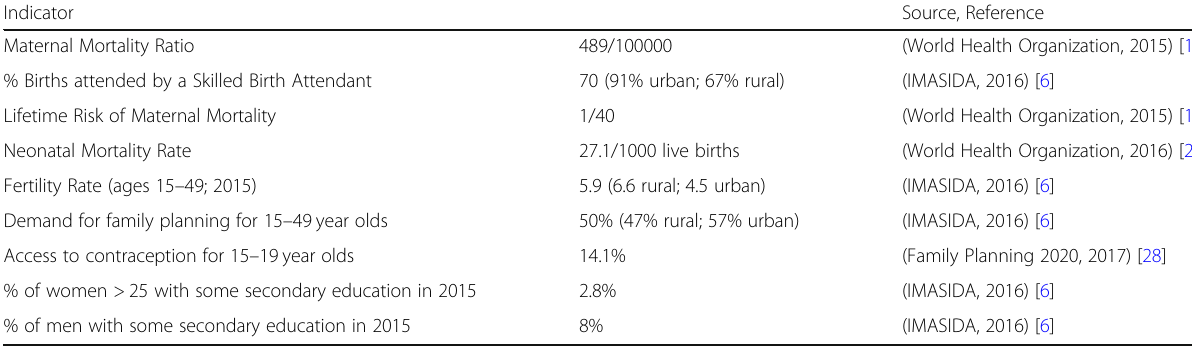
Table 1 Maternal and child health indicators in Mozambique